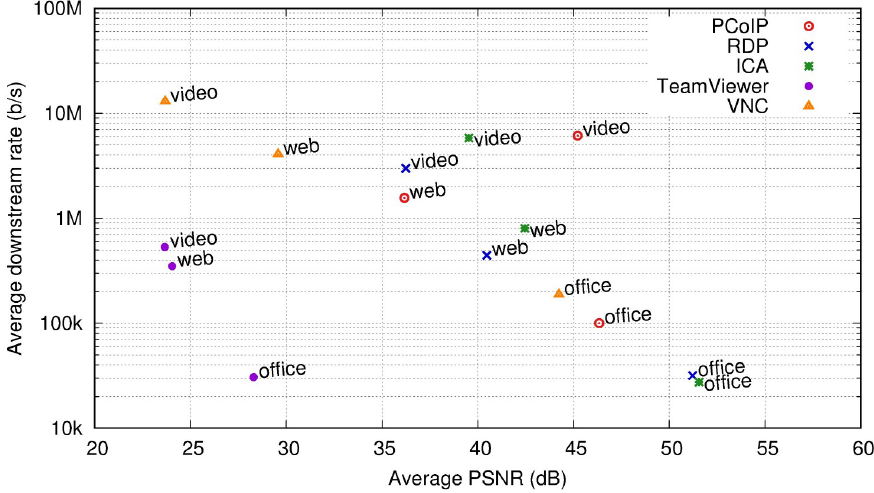
Fig 16. Comparison of average downstream rate vs. average PSNR per user profile and remote desktop protocol.